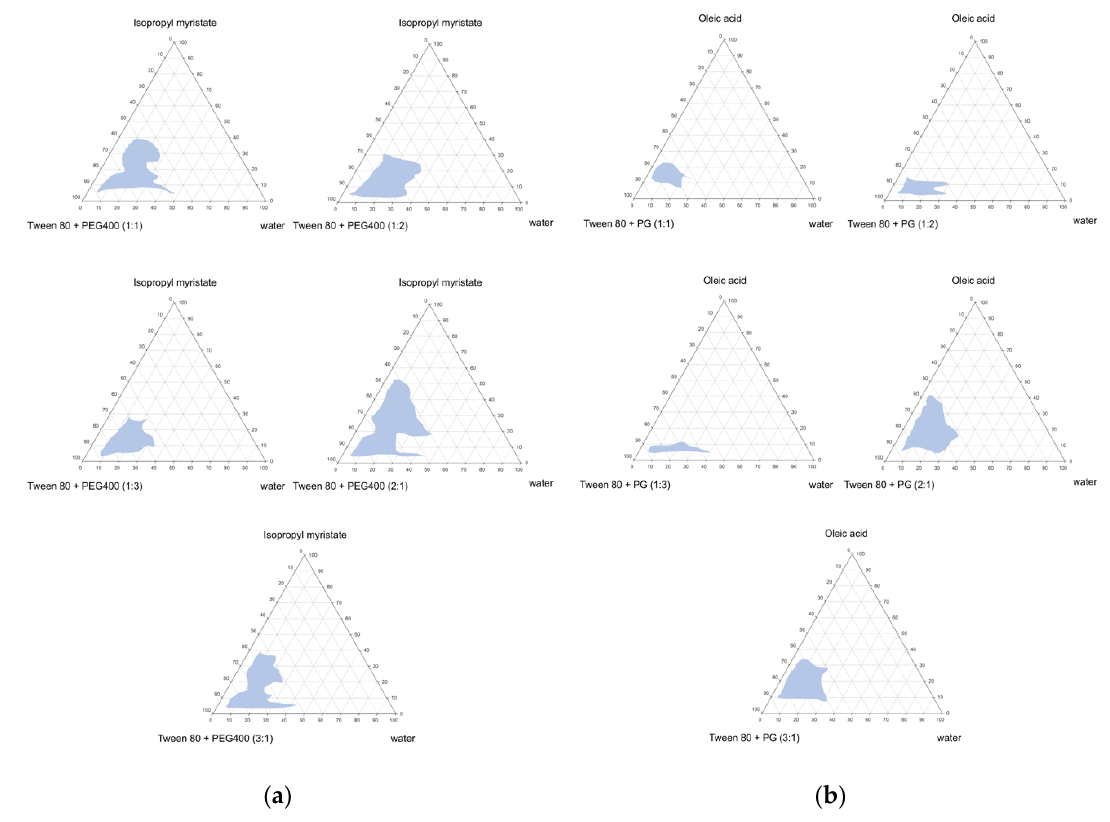
Figure 2. Pseudo-ternary phase diagrams of various ratios of co-surfactant (Tween 80/PEG400), oil (isopropyl myristate) and water ( a ) and co-surfactant (Tween 80/propylene glycol), oil (oleic acid) and water ( b ). The microemulsion regions of the ternary plots are indicated as light blue areas.